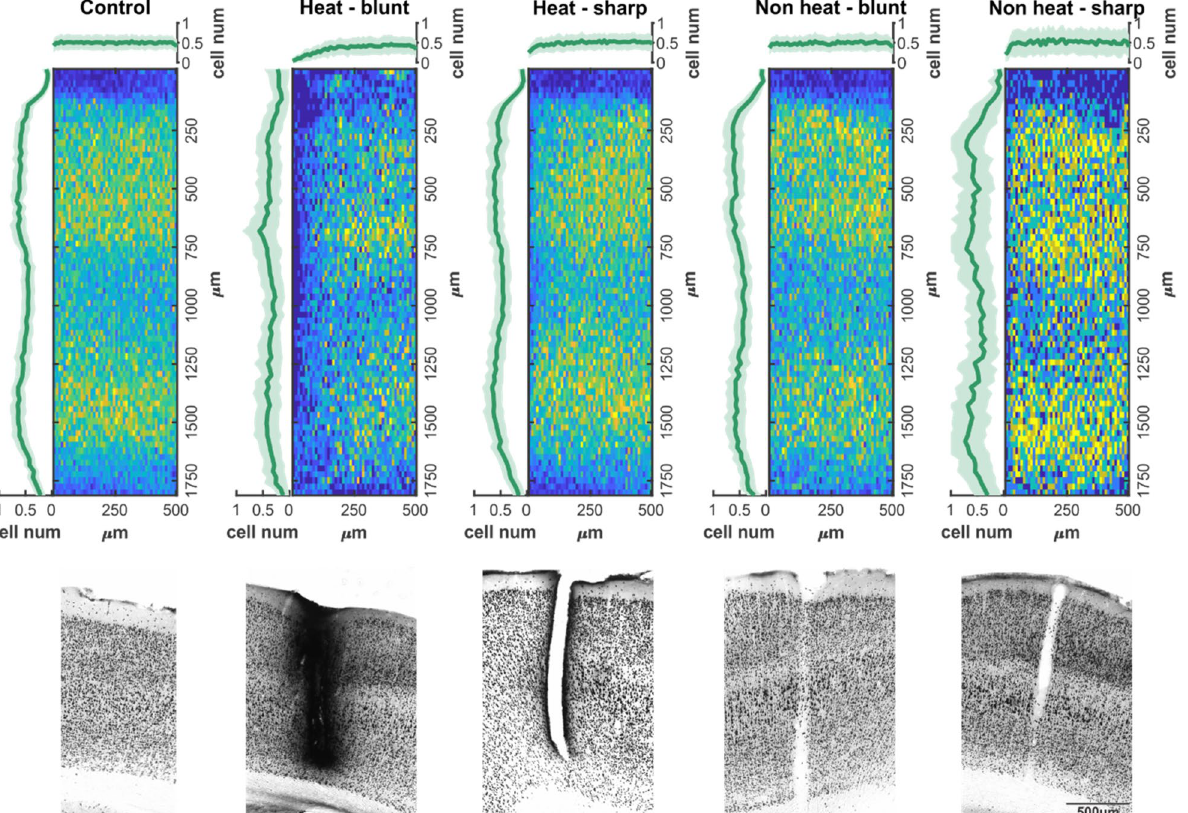
Figure 4. Cell density profiles and two-dimensional distribution of neurons. Top (colored) line: two- dimensional averaged histograms of NeuN immunostained sections from regions of interest in control and probe disrupted cortical areas. Vertical plots show mean cell density as a function of cortical depth, while horizontal traces show mean cell density as function of electrode distance (or in control sections the edge of region of interest). Bottom (grayscale) line: Characteristic examples of NeuN sections for each experimental